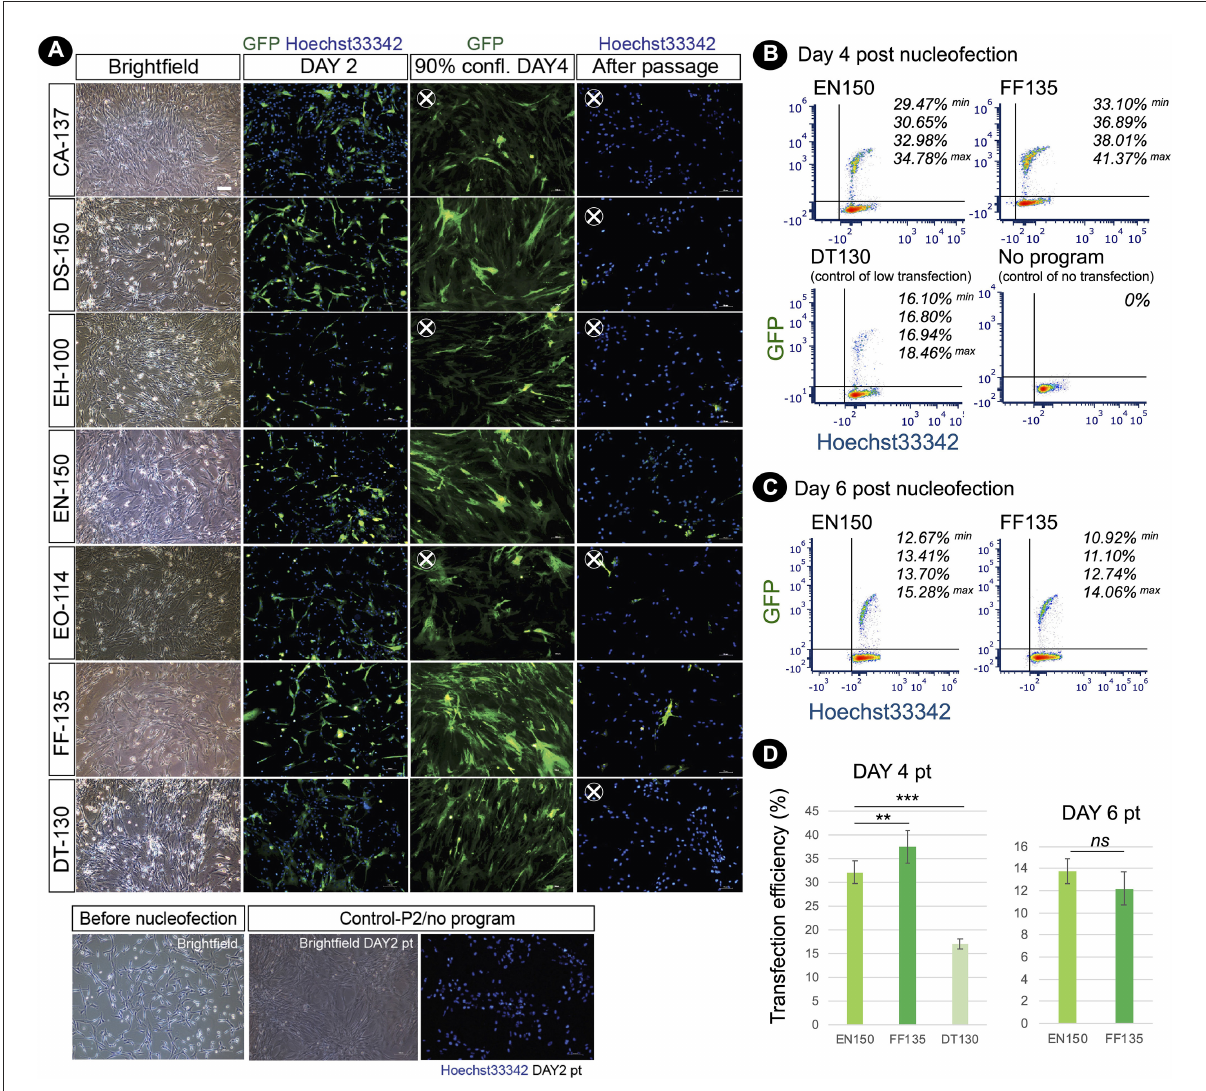
FIGURE4 Nucleofection-based DNA delivery into adult dermal fibroblasts from fishing cat. (A) Fluorescence photographs show the fibroblasts transfected with pmaxGFP expressing GFP using the nucleofection method. Seven different nucleofection programs (CA-137, DS-150, EH-100, EN-150, EO-114, FF-135, and DT-130) were examined. Photos were taken on day 2, day 4 (90% confluency), and day 6 (day 2 after subculture) post-nucleofection. Nuclei were counterstained with Hoechst33342 (blue). At day 4 post-nucleofection, CA-137, EN-150, and EO-114 conditions contained a smaller amount of GFP + cells and were removed for further analysis (X). After passaging, DS-150 and DT-130 conditions show a smaller number of GFP + cells and were removed for further analysis (X). (B) Cells transfected with the best two nucleofection programs: EN-150 and FF-135 were analyzed by flow cytometry to quantify transfection efficiency. The representative contour plots show the percentage of double GFP + and Hoechst 33342 + cell subsets (4 replicates) at day 4 post-transfection. DT-130 program was used as a control of low transfection, and “No program” indicates a condition of no nucleofection in the presence of P2 solution and pmaxGFP DNA. (C) as in (B) , the contour plots show the percentage of double GFP + and Hoechst33342 + cell subsets (4 replicates) at day 6 post-transfection or day 2 after subculture. (D) Graph shows transfection efficiency of nucleofection (mean ± standard deviation) at days 4 and 6 post-transfection calculated from percentage of double GFP + and Hoechst 33342 + cell subsets [ n = 4, as shown in (B) ]. Asterisks (** and ***) indicate significant differences ( p < 0.05 and p < 0.01, respectively, Student’s t -test), and “ns” indicates not significant ( p < 0.05). pt, post-transfection; confl, confluency.